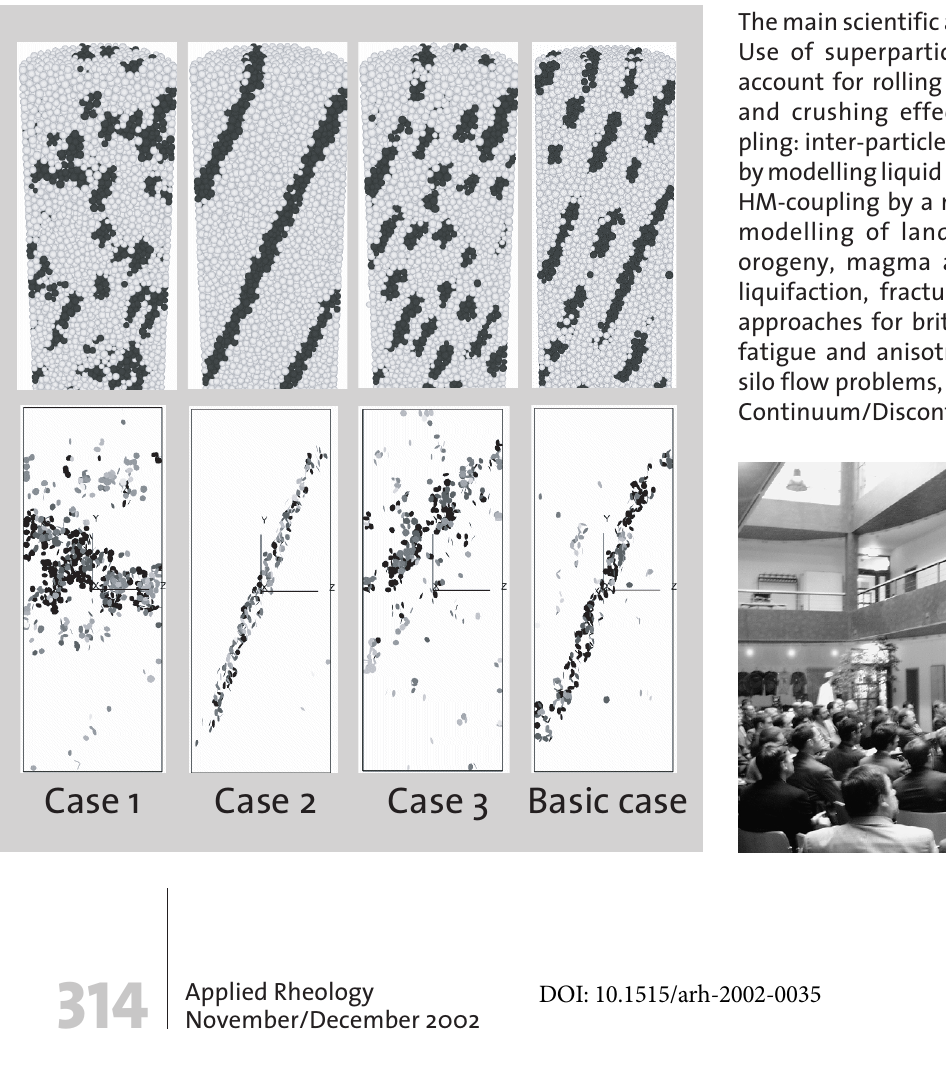
Figure 1 (left below): Model set up (above) and corresponding fracture pattern (below) for uniaxial compression tests for 4 samples with different anisotropy (Wanne T). Figure 2 (right above): Simulated triaxial test of granular material: influence of particle shape on the relation between microscopic contact (ball) friction and macroscopic friction angle (Pierce ME et